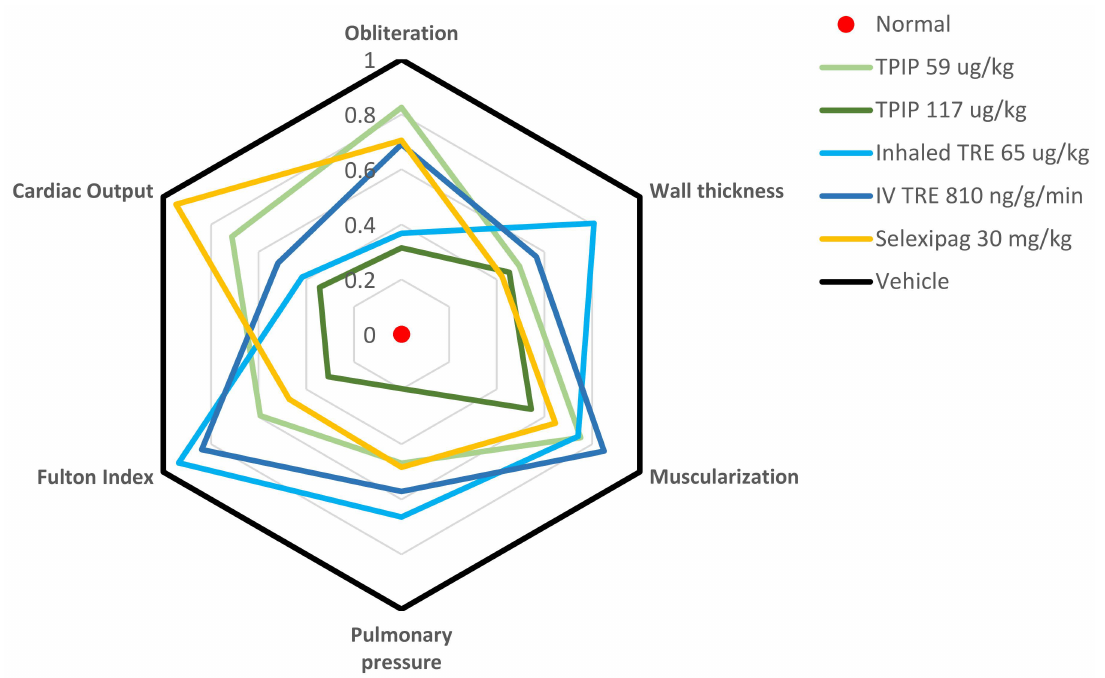
Figure 3. Effect of Treprostinil Palmitil Inhalation Powder (TPIP) in a Sugen/Hypoxia (Su/Hx) rat Pulmonary Arterial Hypertension (PAH) model. This spider graph visually depicts the various readouts from the Su/Hx model including indices of hemodynamics (pulmonary arterial pressure), right ventricular hypertrophy (Fulton index, cardiac output), and vascular remodeling (wall thickness, muscularization and obliteration). In the graph, the individual parameters are represented on separate axes radiating out from the center of the figure. Each parameter is normalized between the normal healthy state (a score of zero, at the center of the figure) and the vehicle control representing the injury after exposure to Su/Hx (a score of 1, at the periphery of the figure). The findings for each compound are depicted in various colors. In this type of figure, the closer that the lines are to the center, the more efficacy they demonstrate. Fulton Index = weight ratio of Right Ventricle/(Left Ventricle + Septum), Pulmonary Pressure = mean Pulmonary Arterial Pressure, Obliteration = percentage (%) of non- obliterated vessels, Wall thickness = Small vessel wall thickness, Muscularization = % of muscularized vessels, Cardiac Output = amount of blood pumped by the heart per minute. Adapted from